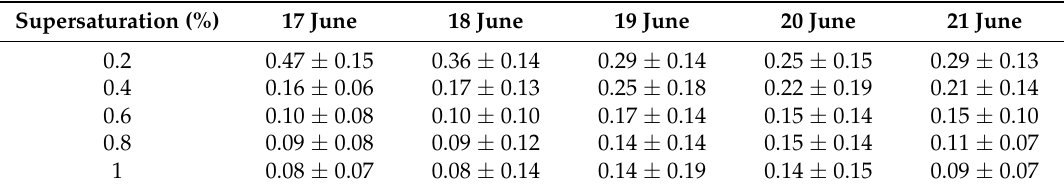
Table 1. Hygroscopicity parameter κ as derived from the CCN measurements for the five different levels of supersaturation.